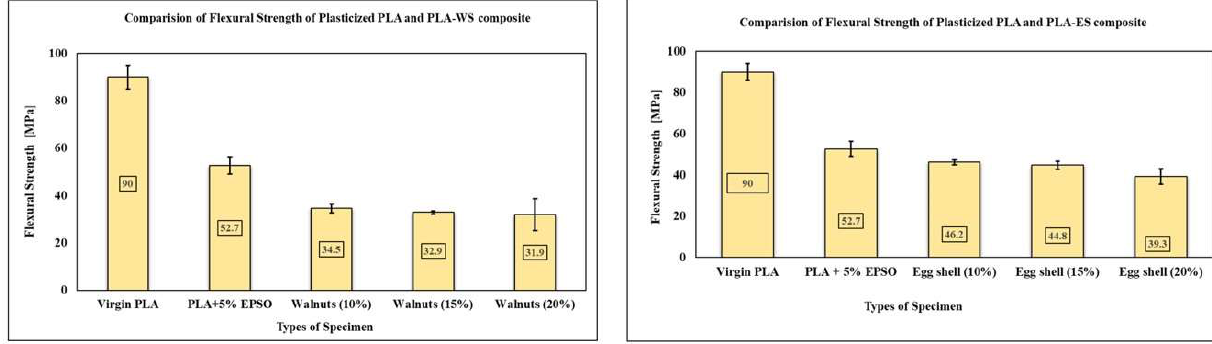
Figure 8. Flexural test result—Flexural strength [MPa] of PLA–ES composite compared with Virgin PLA.